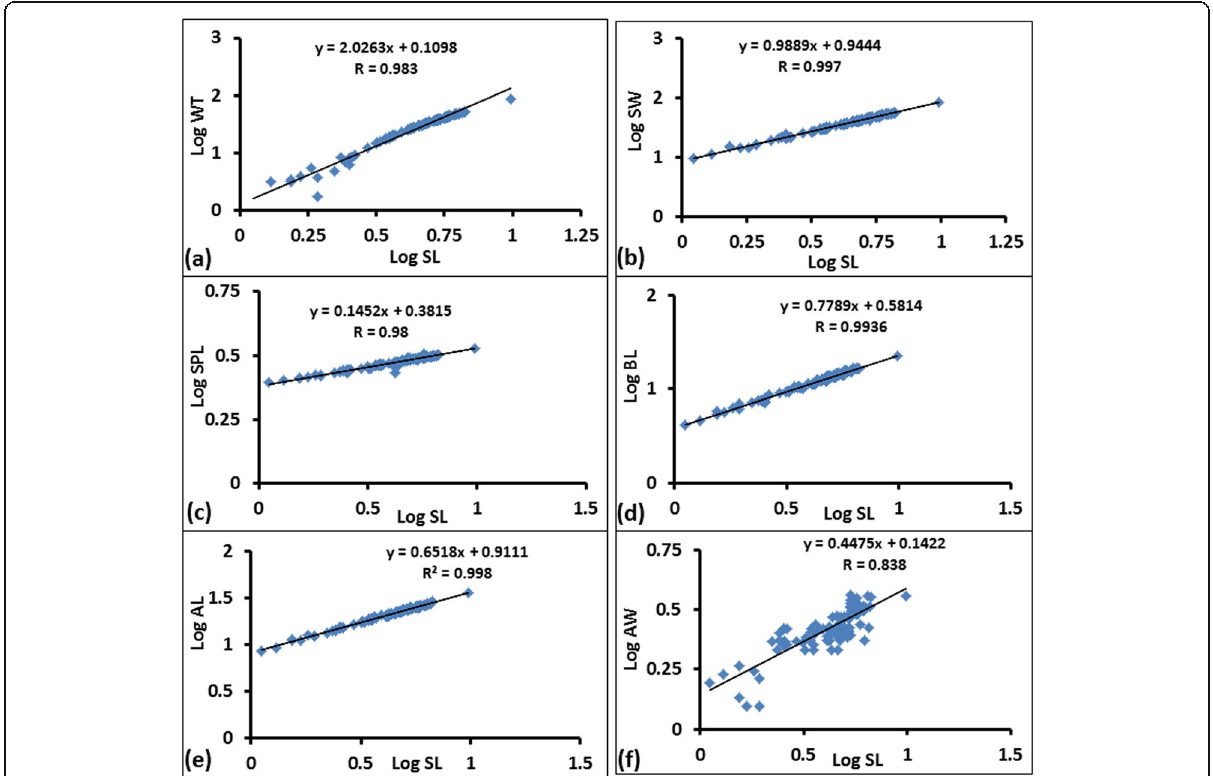
Fig. 3 Relationships between different parameters by taking logarithm of parameters. WT, shell weight; SW, shell width; SL, shell length; SPL, spire length; BL, base length; AL, aperture length; and AW, aperture